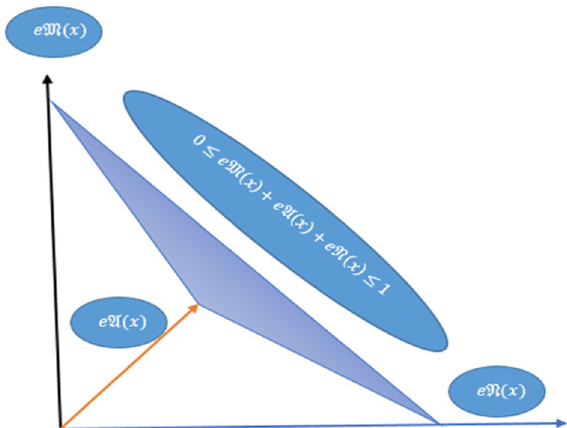
Figure 1. Space of all PFS ft Ns